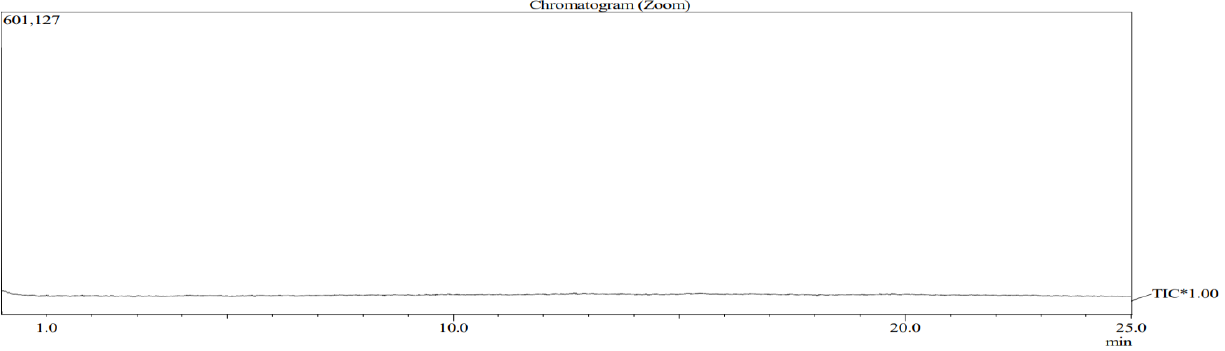
Figure 7. Chromatogram of blank analysis.